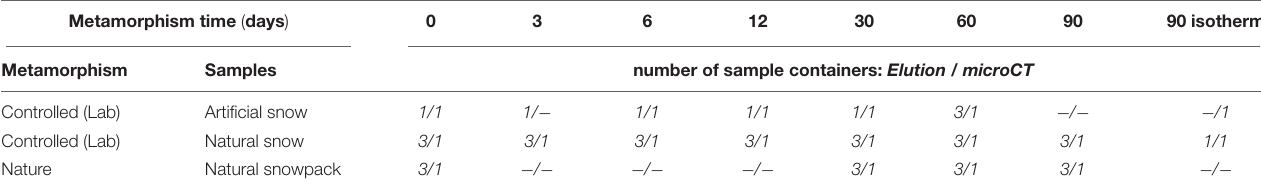
TABLE 2 | Combinations of metamorphism type and snow examined in this